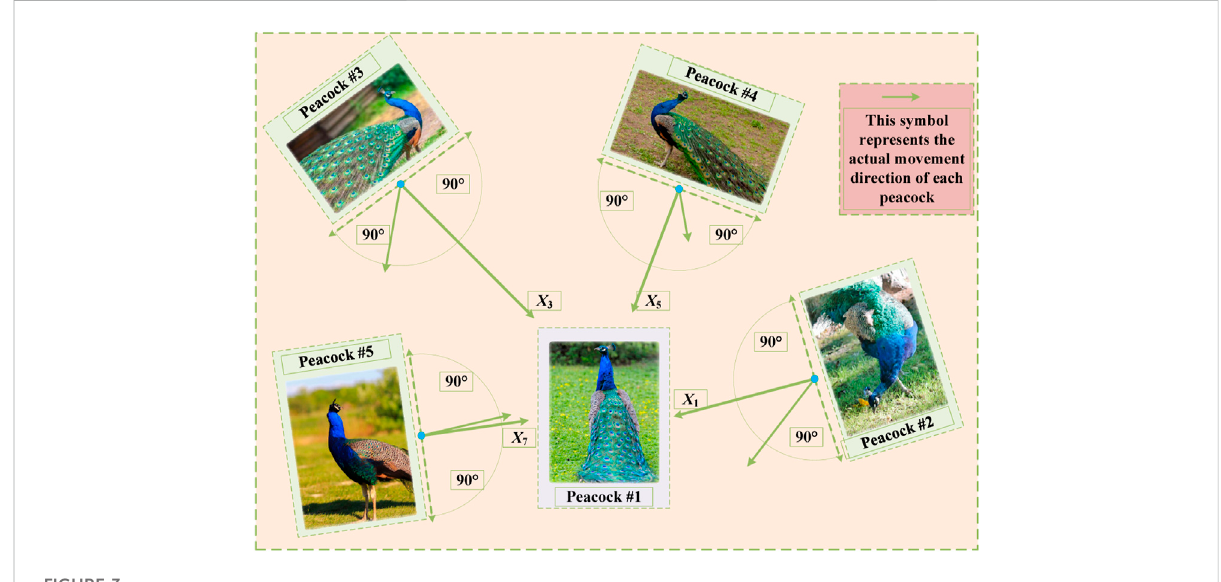
FIGURE 3 Interaction mechanism among different